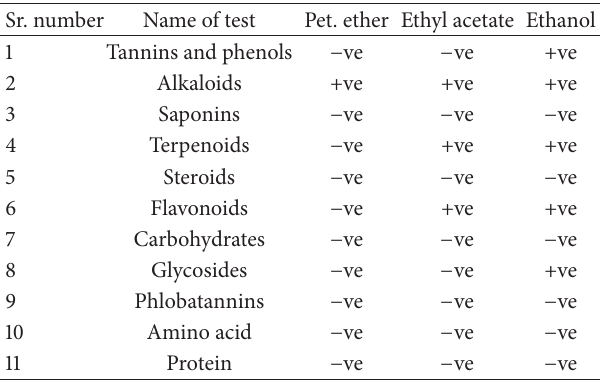
Table 1: Phytochemical investigation of F. religiosa Linn. leaves. Sr. number